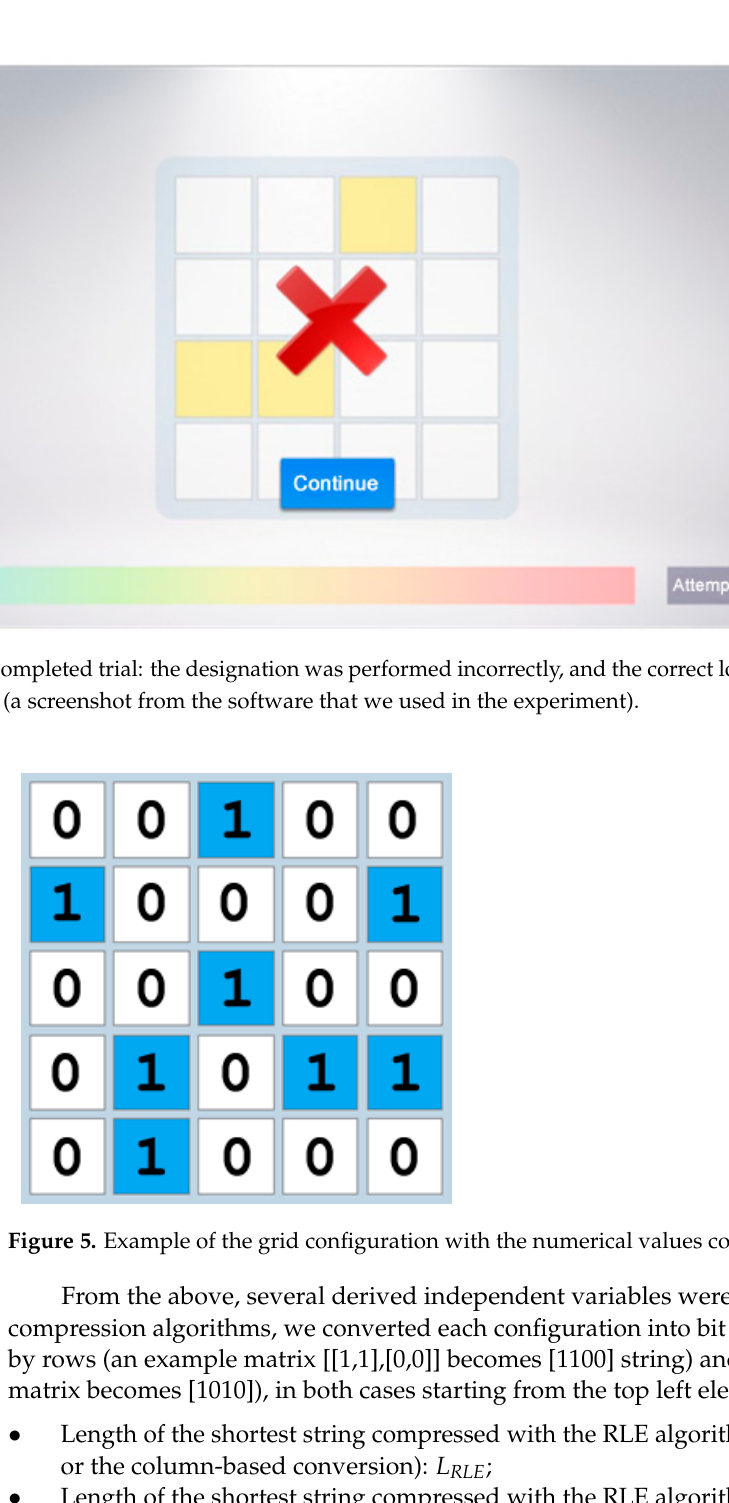
Figure 6. Examples of the grid configuration with the numerical values corresponding to the cells.